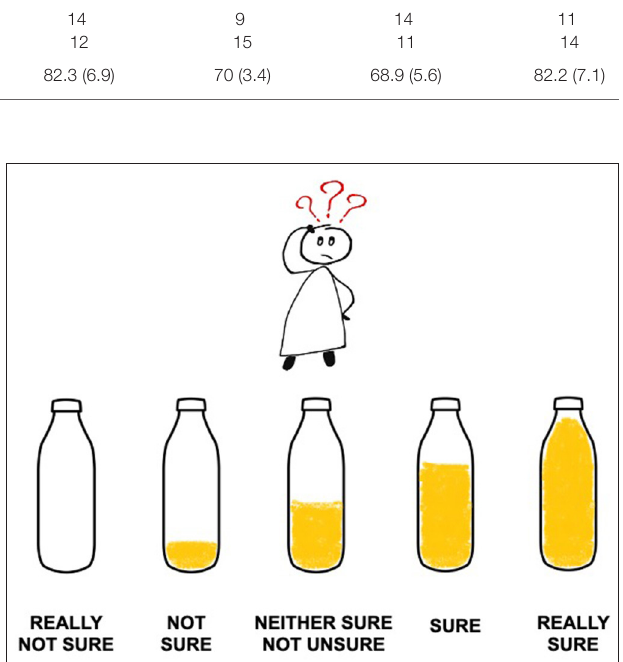
FIGURE 1 | Five-point confidence scale. The drawings used in this figure are available as a free download in the FreeIMG.net